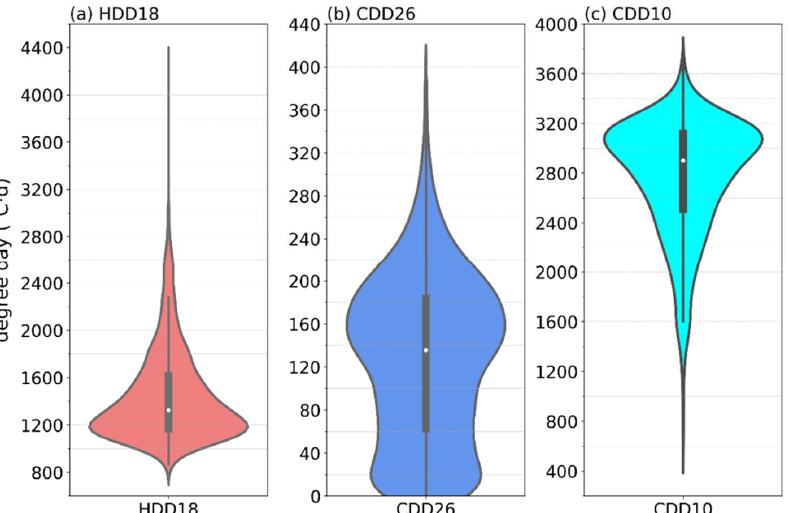
Figure 3. Violin diagram of HDD18 ( a ), CDD26 ( b ), and CDD10 ( c ) in Chongqing (the wider the violin plot, the greater the density; the white dot in the middle of the thick black bar in the middle of the violin plot indicates the median, the top and bottom edges of the thick black bar indicate the upper and lower quartiles, respectively, and the thin black line extending from the thick black bar indicates the 95% confidence interval).